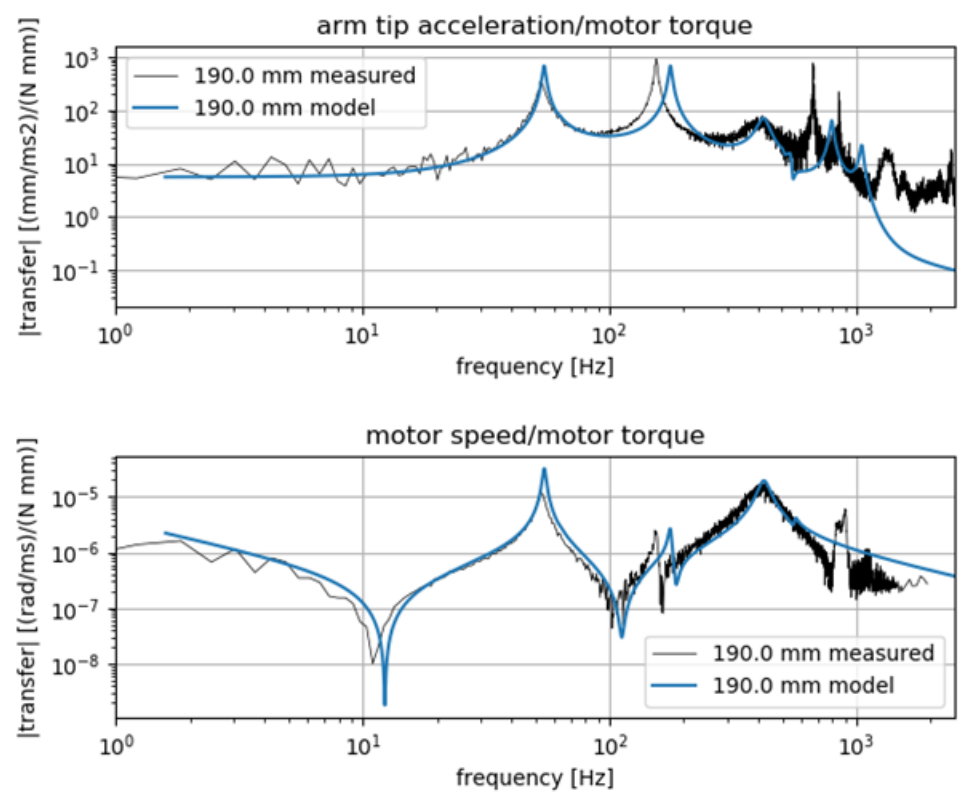
Figure 13. Reduced model with modal damping compared to measurements: tip acceleration ( top ) motor velocity ( bottom ) for a particular value of load-mass position set to 190